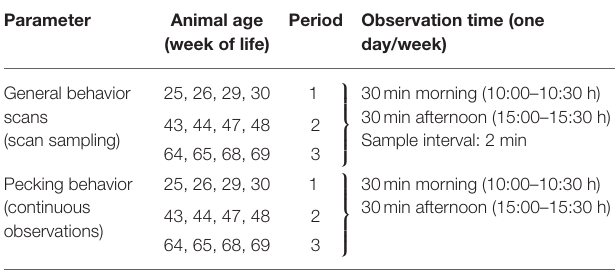
TABLE 1 | Overview of behavioral observations performed at different times during the laying